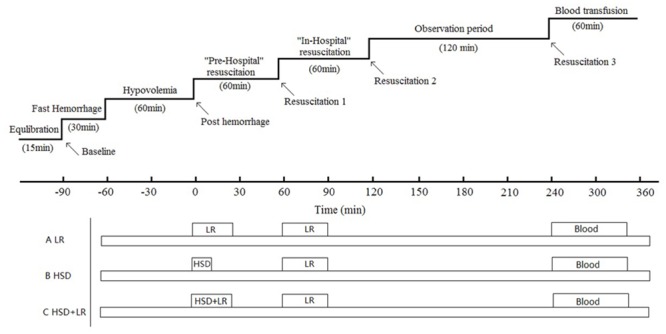
Experimental protocol.Following an equilibration period, baseline (BL) measurements of all parameters were recorded, and subsequent blood was rapidly withdrawn until a mean arterial pressure of approximately 50±5 mm Hg was reached and maintained for another 60 minutes (hypovolemia period). All measurements were then recorded (post-hemorrhage, PH, time = 0 min), and the animals were separately resuscitated with HSD, LR or HSD+LR over 60 minutes (Resuscitation1, R1, time = 60 min). Then, during the in-hospital resuscitation phase, LR were started as a transfusion for all animals until the MAP reached 85% of the baseline value (Resuscitation 2, R2, time = 120 min). After a two-hour observation period (Resuscitation 3, R3, time = 240 min), all animals received blood transfusions (70% of their blood loss) so that they would survive for three days of observation. Then, the dogs were sacrificed with an IV bolus injection of pentobarbital, and their tissues including their kidneys, lungs, liver and intestines were obtained for pathological analysis.